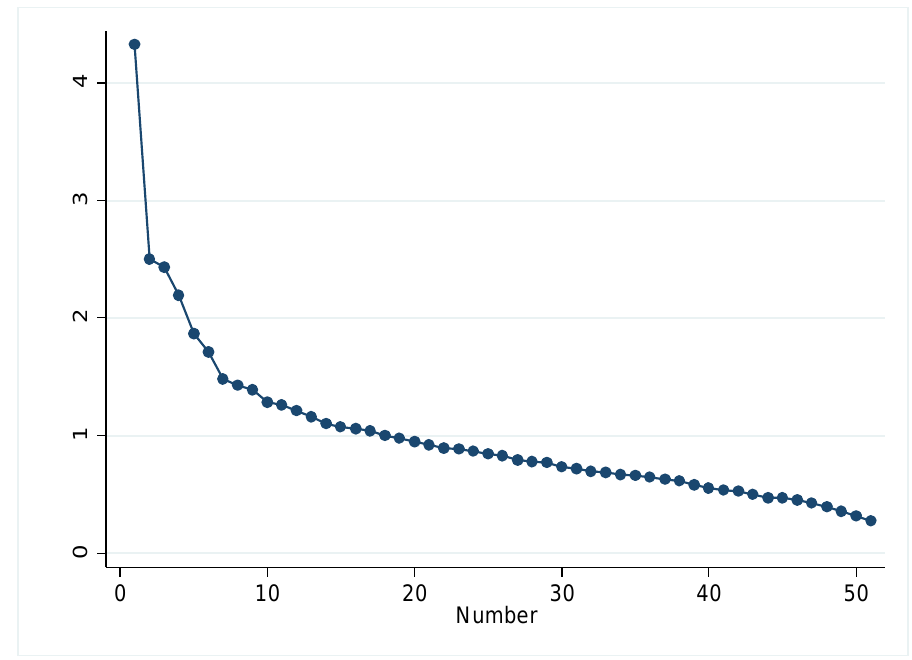
Figure 1. Scree plot of eigenvalues from principal component analysis (PCA) following orthogonal rotation. Scree plot indicating variance explained by number of principal components retained. Components with an eigenvalue > 2 were retained.